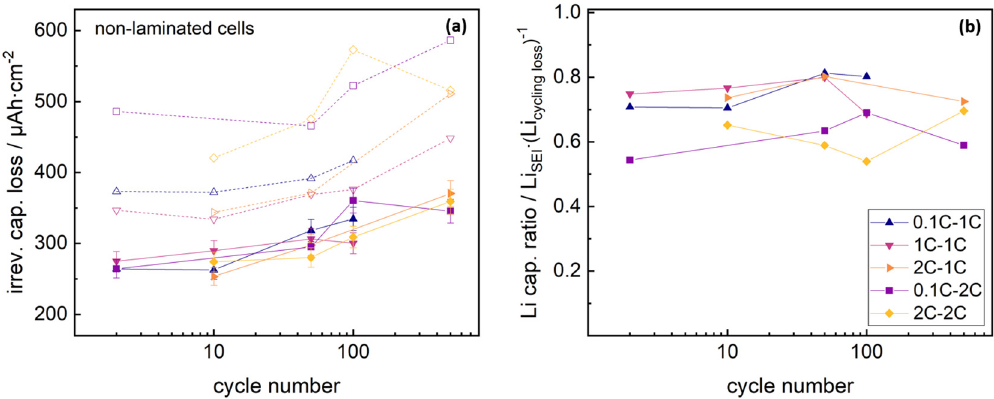
Figure 4. ( a ) Active lithium loss of non-laminated cells calculated from capacity-fade in the cycling test (hollow symbols, dotted lines) compared to lithium bound in a solid electrolyte interphase (SEI), detected post-mortem with NDP (solid symbols, solid lines) and ( b ) irreversibly lost lithium fraction bound in SEI.